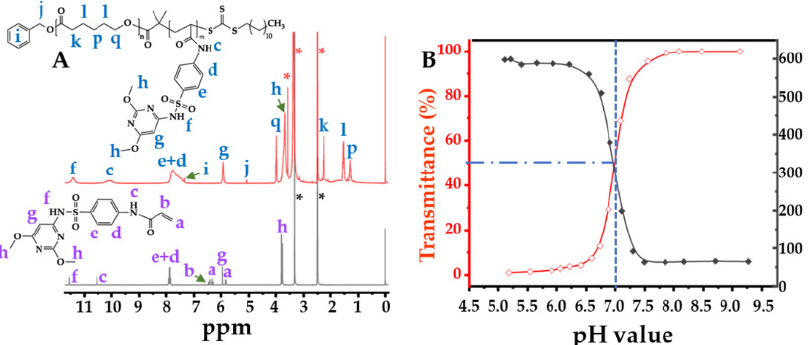
Figure 2. Structure and pH responsive of the PCL- b -pSMA: ( A ) 1 H NMR spectrum of PCL- b -pSMA, marking all characteristic peaks; ( B ) pH-dependent transmittance curve and diameter variation of PCL- b -pSMA, showing a p K a at 7.0.